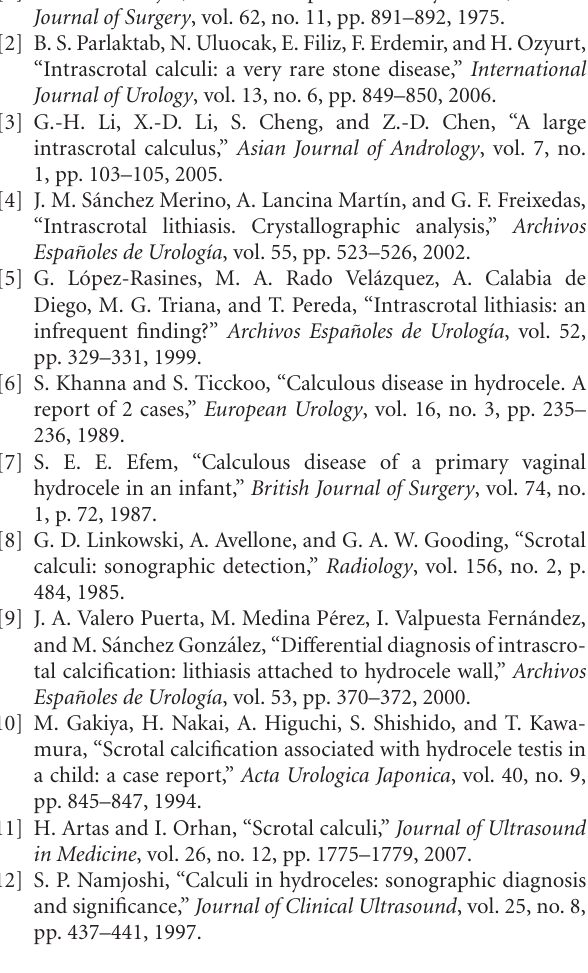
Figure 2: Infrared spectrophotometry of hydrocele stone (a) center of the stone, (b) outer of the